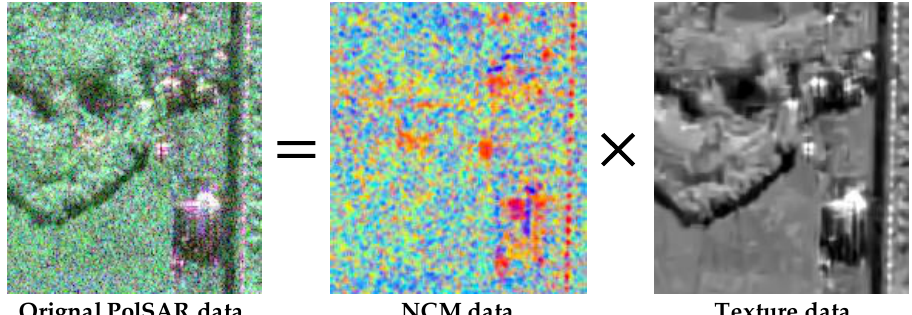
Figure 7. Example of NCM and texture data estimated by a SIRV estimator [3] .